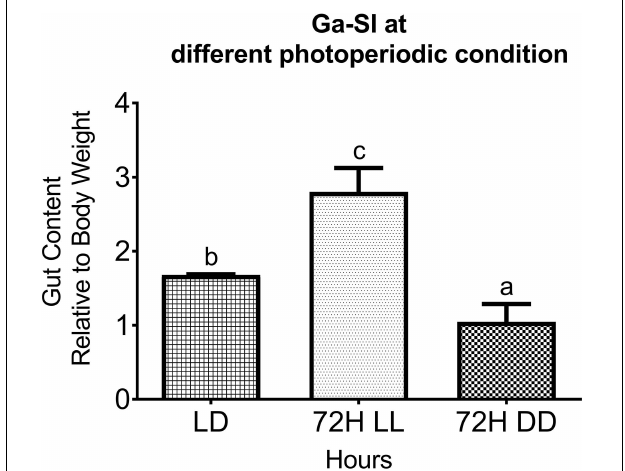
FIGURE 1 | Ga-SI (Gastrointestinal Somatic Index) in different photic conditions (LD, LL, and DD). Food intake as a Ga-SI (intestine food content relative to body mass) at different photoperiodic conditions (LD, LL, and DD) after 72 h of incubation. Results are expressed as mean ± SEM ( n = 5). Different letters indicate significant differences evaluated by one-way ANOVA [ F (2,6) = 43.743, p = 0.000] with the Tukey post-hoc test ( p <